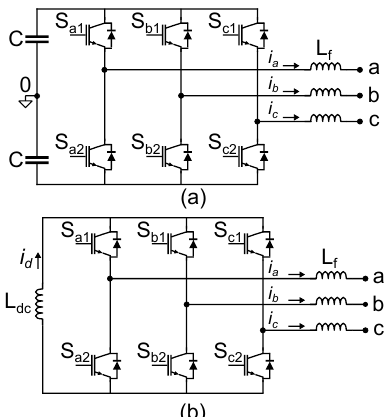
Figure 6. Main topologies of two-level three-wire APFs: ( a ) voltage source converter (VSC); ( b ) current source converter